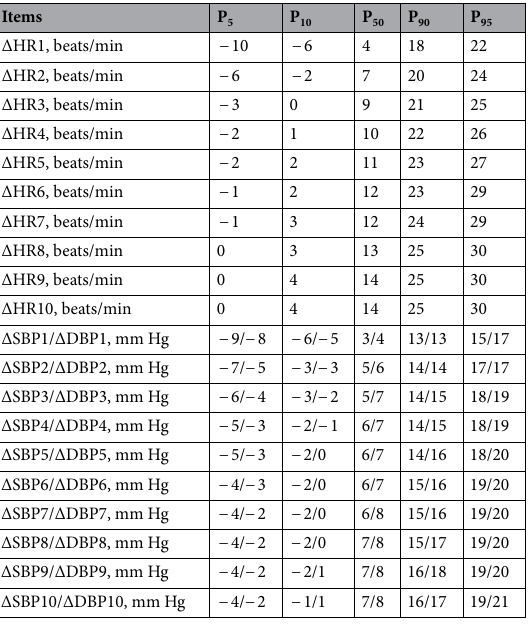
Table 1. Percentiles of changes in heart rate and blood pressure between the supine position and sitting position. ∆HR means the maximum heart rate within a relevant duration after sitting minus the supine heart rate. ∆SBP/∆DBP means the maximum systolic blood pressure and diastolic blood pressure within a relevant duration after sitting minus the corresponding values in the supine position. HR heart rate, SBP systolic blood pressure, DBP diastolic blood pressure.